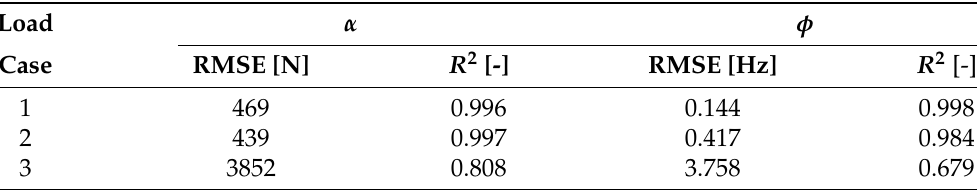
Figure 24. Pirelli Tower. Parity plots showing the regression outcomes for the load amplitude α ( left column ) and the load frequency φ ( right column ) for the three considered load cases. Table 6. Pirelli tower. RMSE and correlation coefficient R 2 of the regression outcomes for the load amplitude α and the load frequency φ for the three considered load